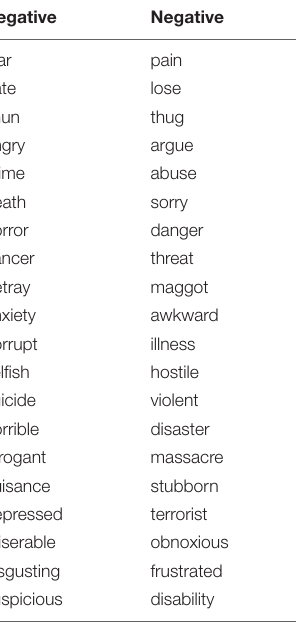
TABLE 1 | Word lists used in the